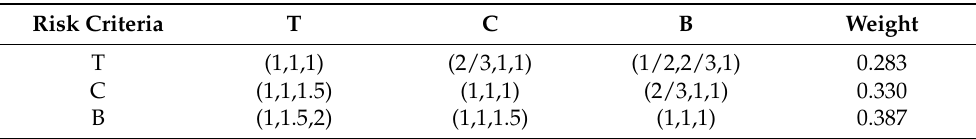
Table 5. Fuzzy pair-wise comparison matrix for the three risk factors. Risk Criteria